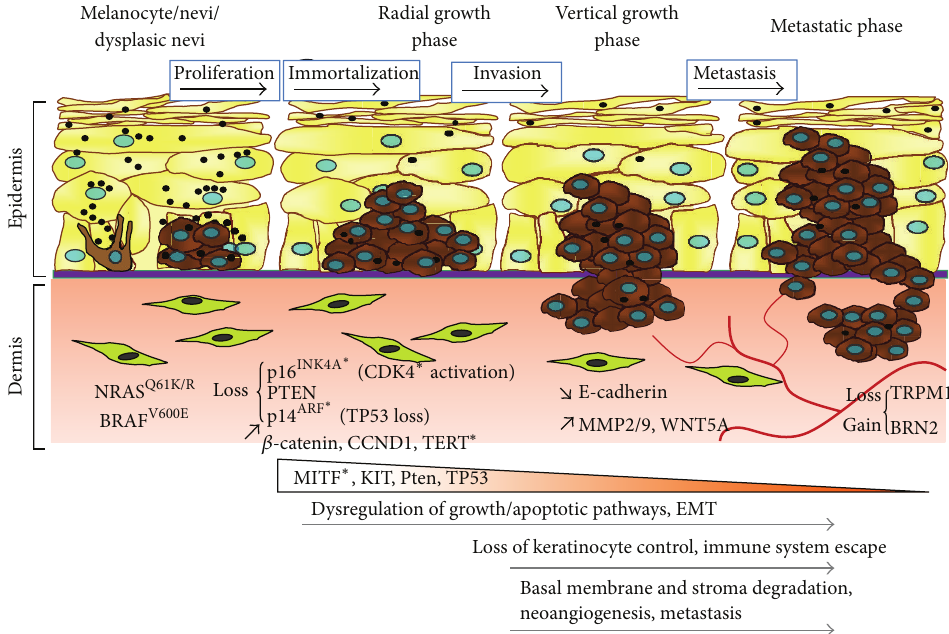
Figure 3: Hypothetical model of Melanoma development. In 25% of cases, melanoma derives from a pre-existing nevus through a multistep processregulatedbyakeysetofgenes.Cellsmustacquiresuccessivegeneticlesionspriortoformingtumorsandmetastases.Asterisksindicate genes mutated in the